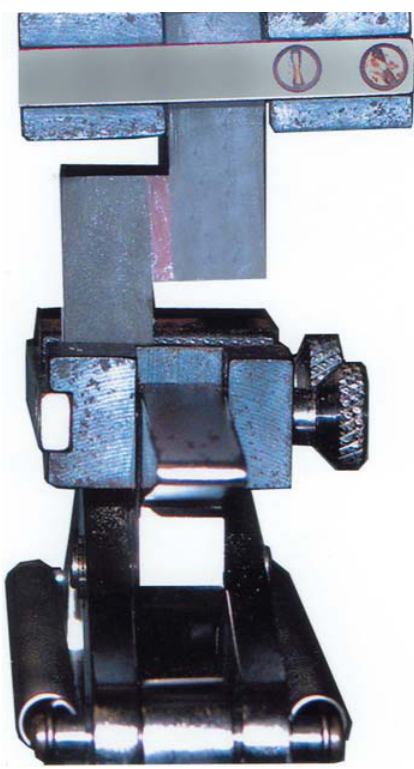
FIGURE 3- Tensile strength specimen in the universal testing machine